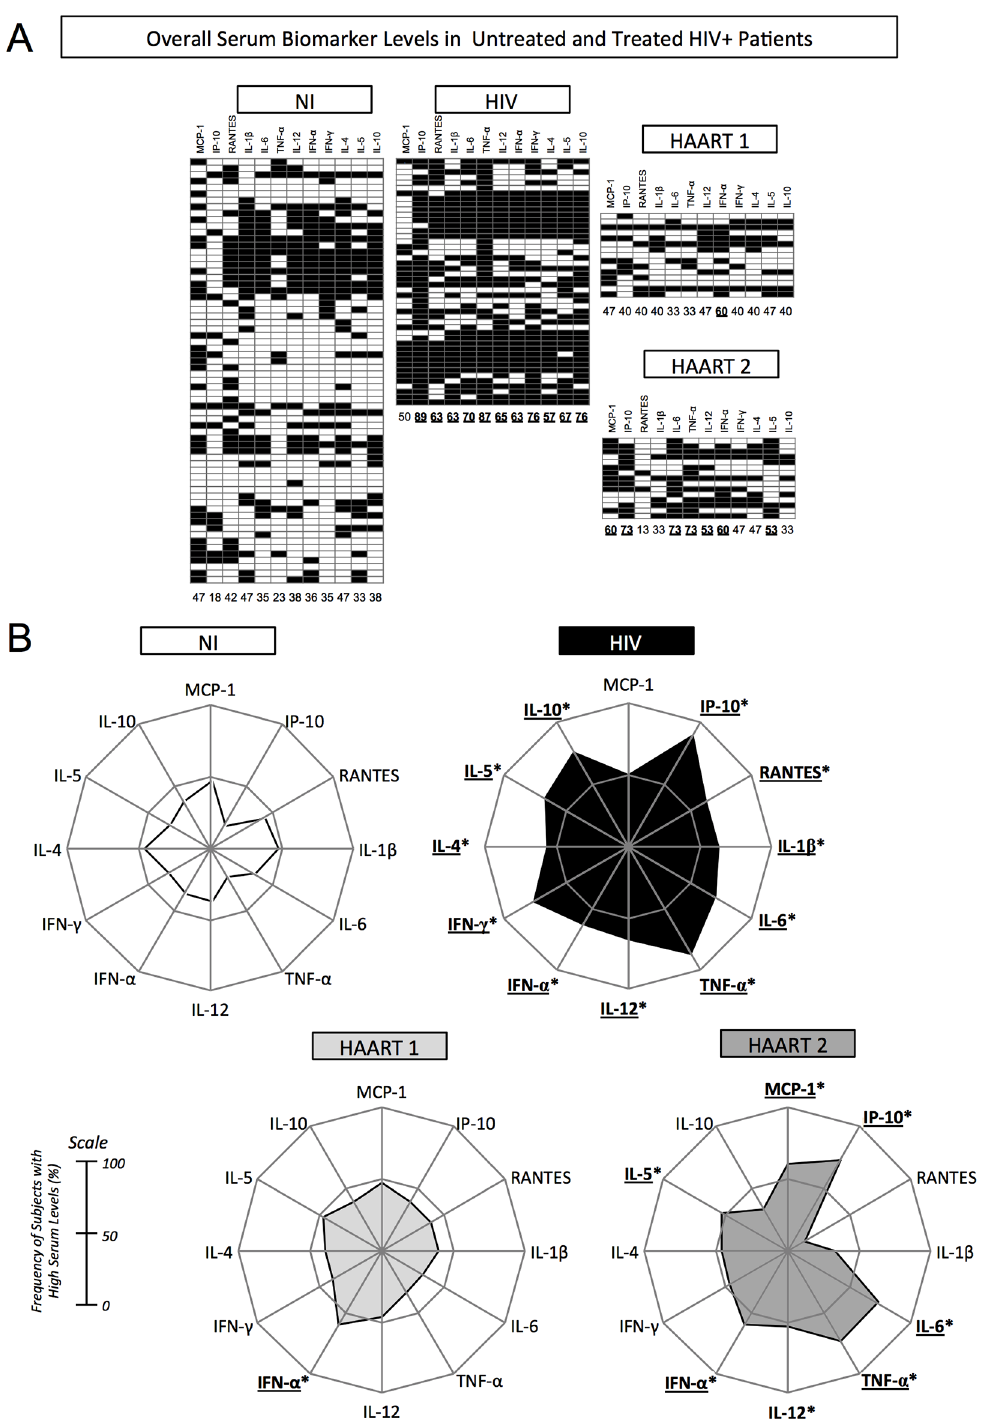
Fig 2. Immunological biosignature of NI, untreated, and treated HIV+ patients (HAART 1 and HAART 2). Plasma concentration of MCP-1, RANTES, IP-10, IL-1 β , IL-6, TNF- α , IL-12, IFN- α , IFN- γ , IL-4, IL-5, and IL-10 was used for categorical classification of NI, HIV, HAART 1, and HAART 2 groups between high and low producers of a given immunological biomarker. A) Black and white diagrams represent high and low producers of each cytokine, respectively. Each lane represents a cytokine and each block represents the pattern of cytokine production of each patient. Numbers below each lane represent the frequency of high producers of the cytokine tested. B) Radar charts summarize the percentage of high producers of each clinical group studied. When the frequency of high producers was greater than 50% (on a scale of 0 – 100%), the result was highlighted.